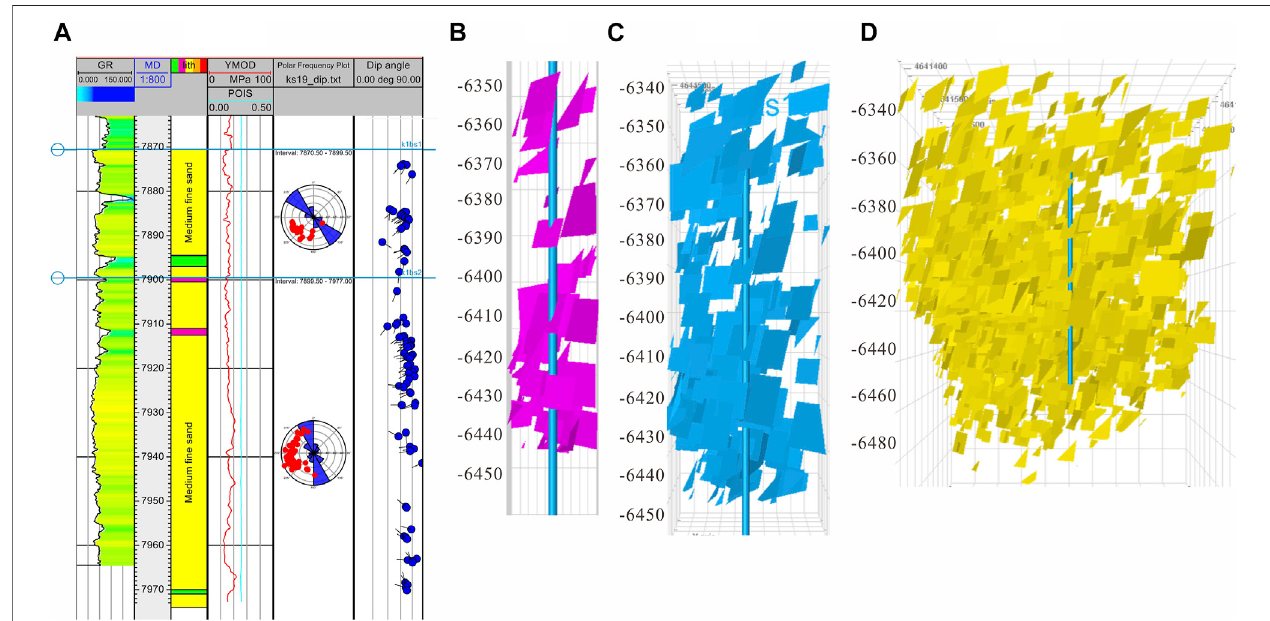
FIGURE 10 | The diagram of well ks19 fracture connectivity prediction. (A) is the natural fracture development pro fi le at the wellbore position of ks19, (B) is the prediction diagram of natural fracture development 50 m around the wellbore; (C) is the prediction diagram of natural fracture development 100 m around the wellbore; (D) It is the prediction diagram of natural fracture development 150 m around the